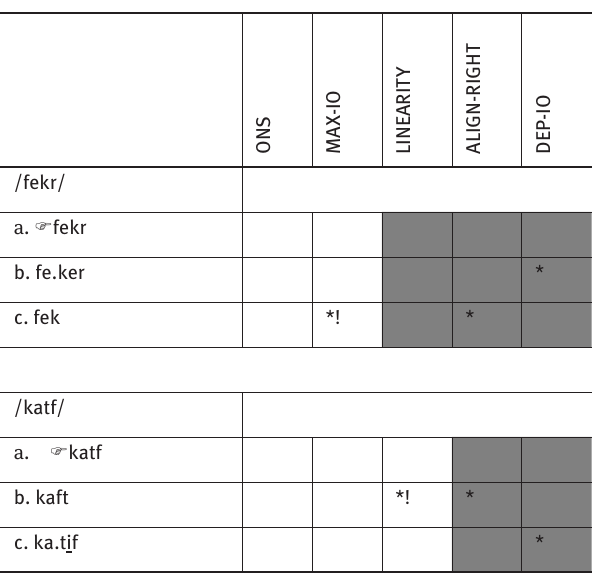
Table 3: ONS>>MAX-IO>>LINEARITY>> ALIGN-RIGHT>>DEP-IO